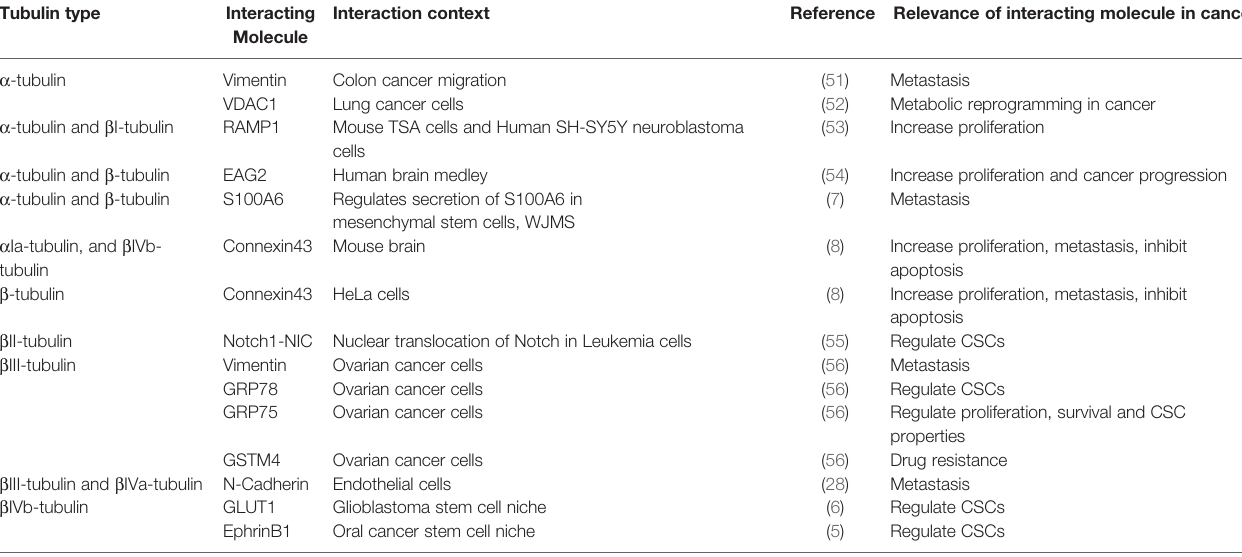
TABLE 2 | Tubulin interacting